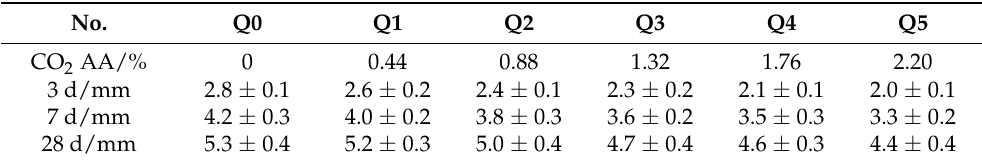
Figure 7. Image of carbonation depth under ultrasonic vibration agitation (28 d) . Table 4. Absorb different amounts of CO 2 and carbonize depth at different ages (ultrasonic vibration agitation) .